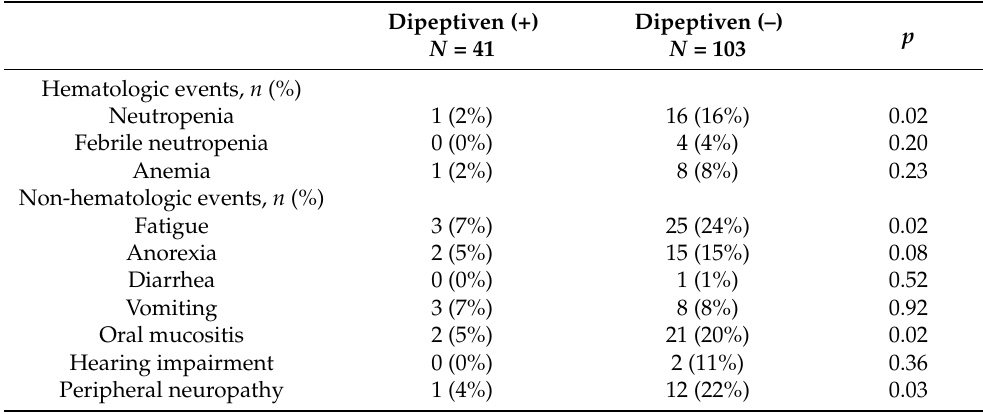
Table 4. Grade 3 to 4 treatment-related adverse effects in 144 nasopharyngeal cancer receiving concurrent chemoradiotherapy, stratified by